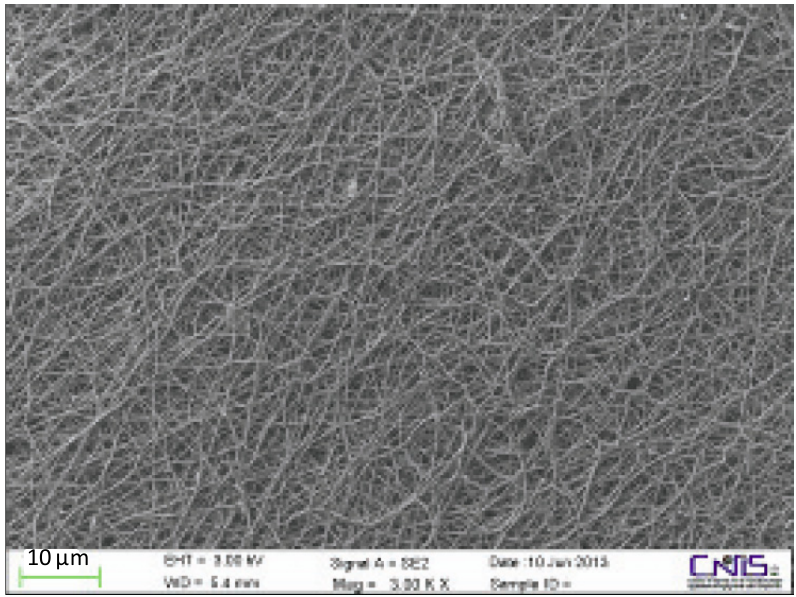
Figure 17. Non-woven tissue obtained by electrospinning at